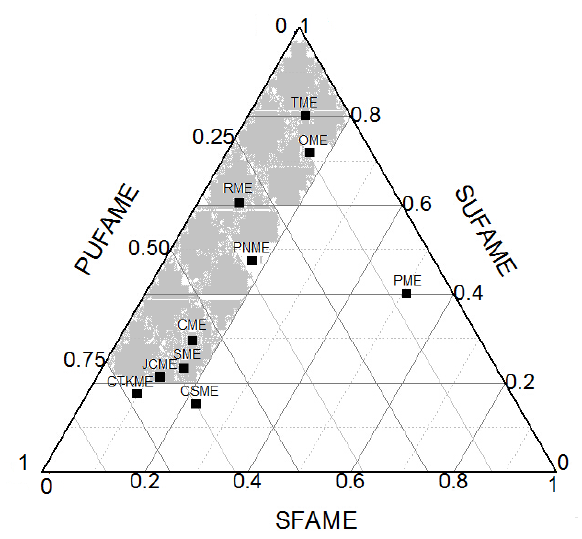
Figure 10. Relationship between low temperature fluidity and oxidation stability of biodiesel and fatty acid methyl esters.